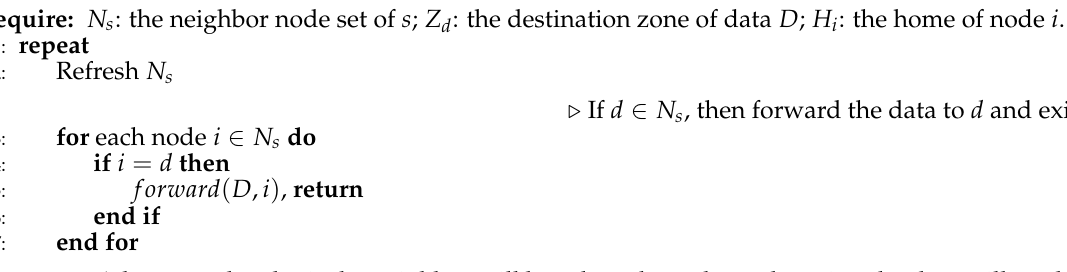
Algorithm 1 The Basic HERO